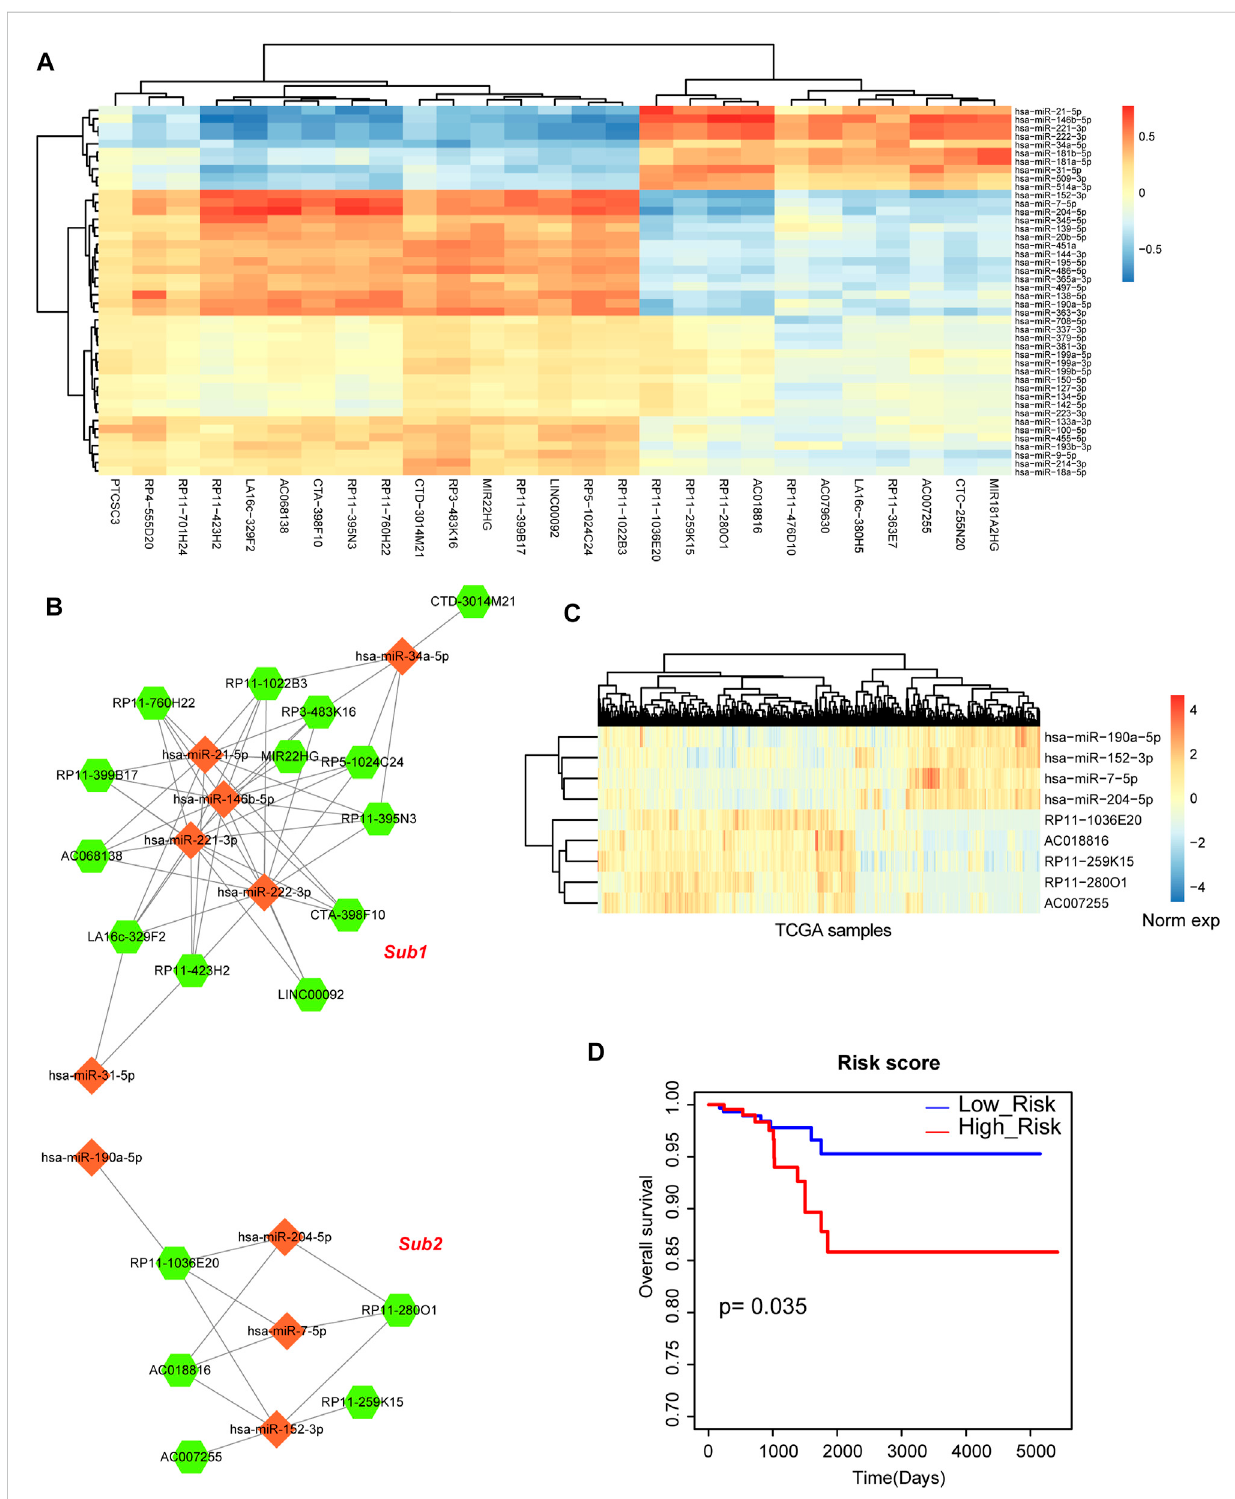
FIGURE 4 Analysis of miRNA-lncRNA network. (A) The heat map of correlations between DE miRNAs and DE lncRNAs. (B) The THCA related miRNA-lncRNA network that contains 2 subnetworks. Orange diamond represents miRNA and green hexagon represents lncRNA. Node size represents degree of node. (C) The heat map of the expression of subnetwork 2. (D) A Kaplan-Meier survival curve of subnetwork